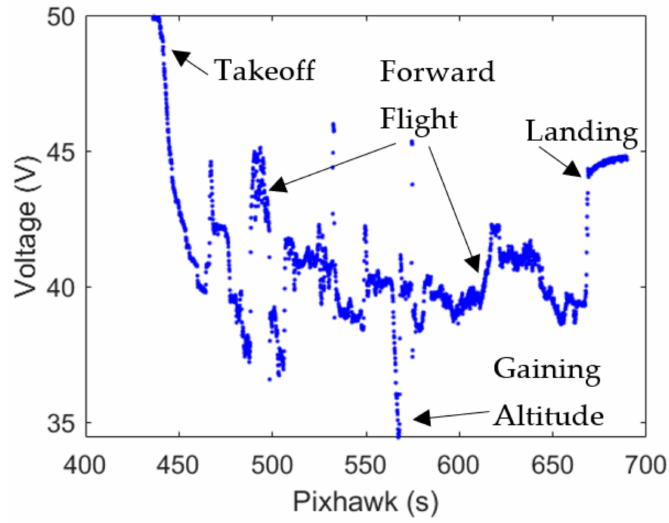
Figure 6. Voltage over the course of the